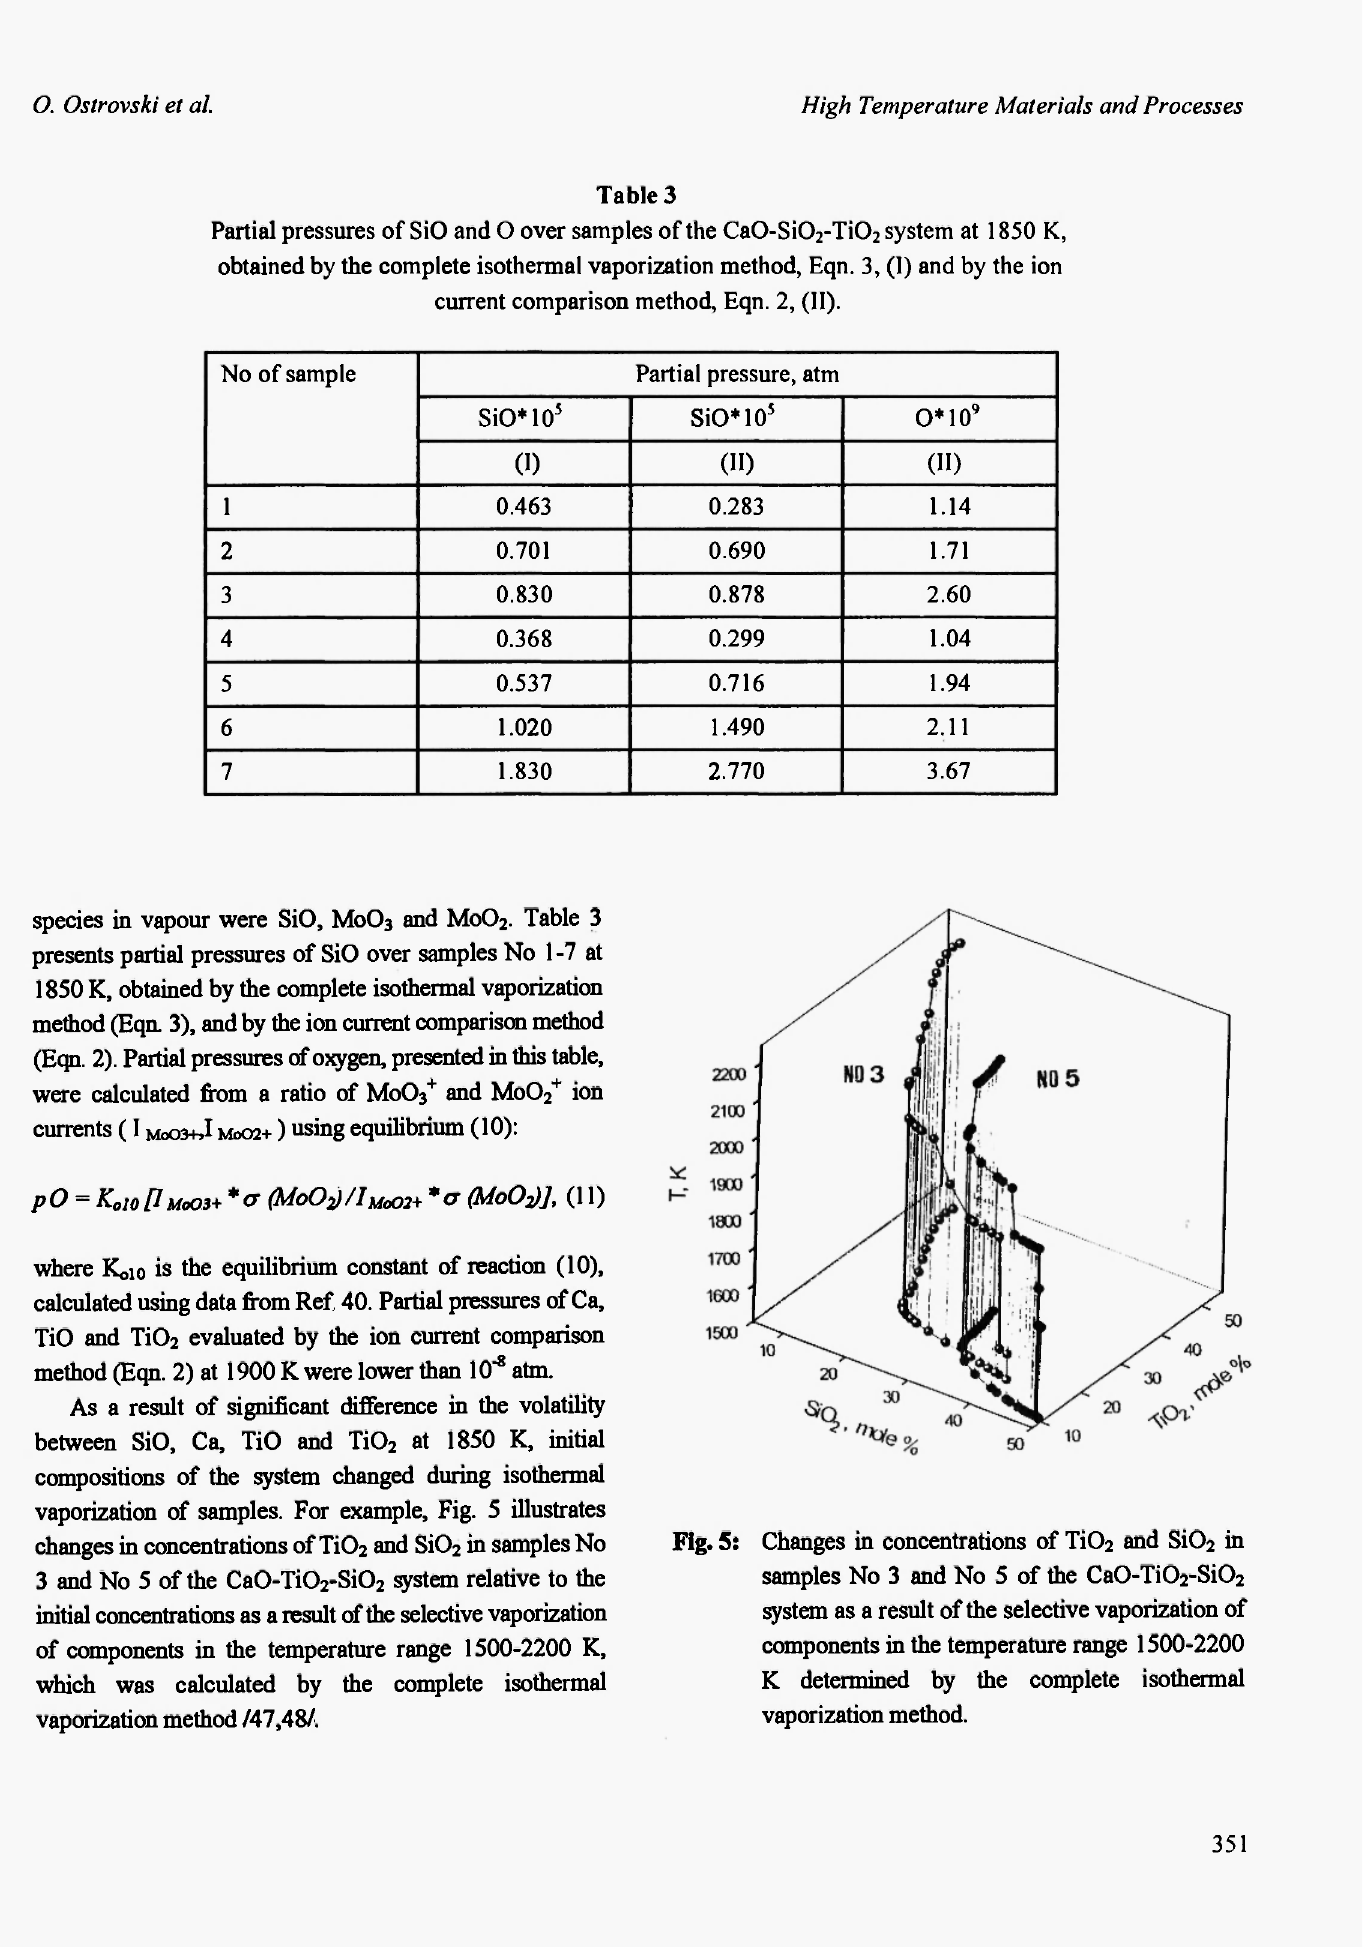
and Si0 in 2 2 -Si0 2 2